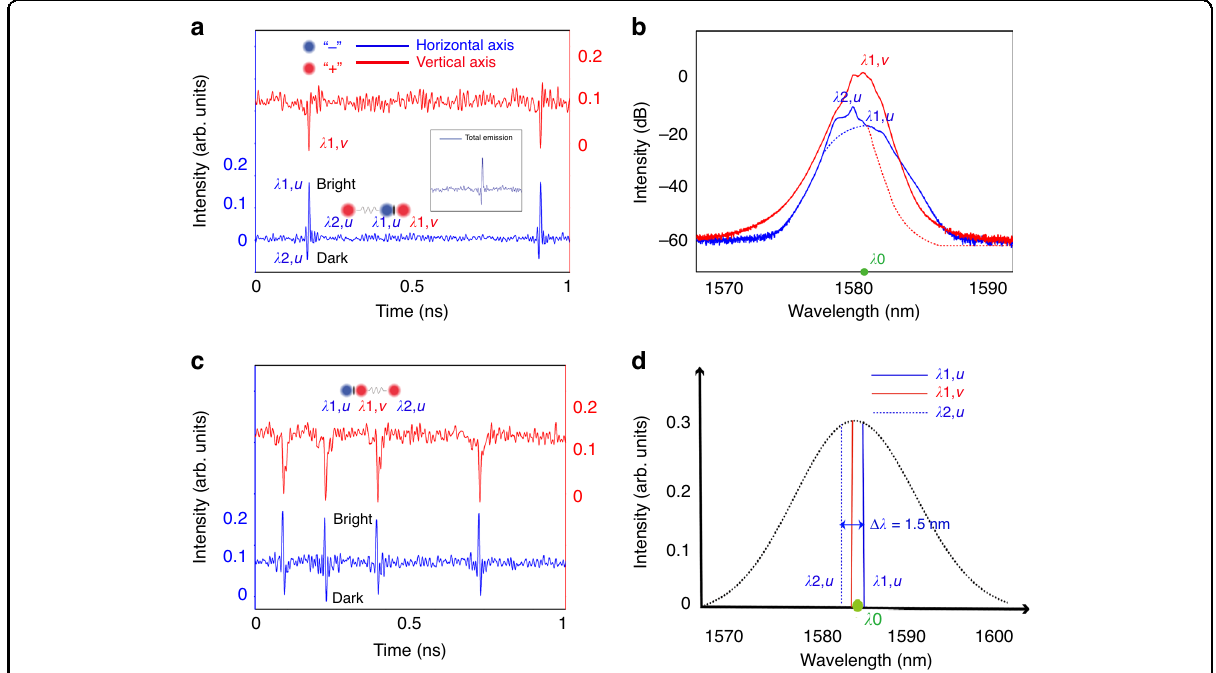
Fig. 5 Two kinds of (2 + 1) PMSs experimentally observed. a A state of (2 + 1) PSMs where DSs are leading the ODBSs. Blue solid line and red solid lines: polarization-resolved laser emissions. Inset: total laser emission of each (2 + 1) PSM. b Polarization-resolved optical spectra of ( a ); blue (red) dashed-line fi tted part: spectrum for the BSs (DSs) formed at the wavelength λ 1, u ( λ 2, u ), λ 0 : central wavelength of the ZGVD point. c Another state of the (2 + 1) PSMs where the ODBSs are leading the DSs. d Schematic of the wavelength relationship of the DSs and BSs, λ 0 : the position of ZGVD point, λ 1, u : central wavelength of the BSs formed along the horizontal polarization axis, λ 2, u : central wavelength of the DSs formed along the horizontal axis, λ 1, v : central wavelength of the DSs formed along the vertical polarization